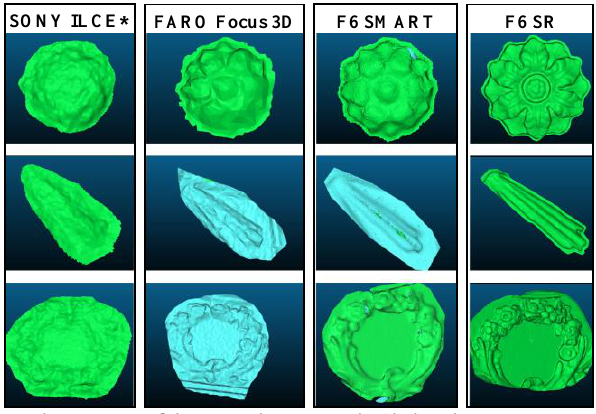
Figure 8. In the column the meshes of the 3 fragments acquired with the different